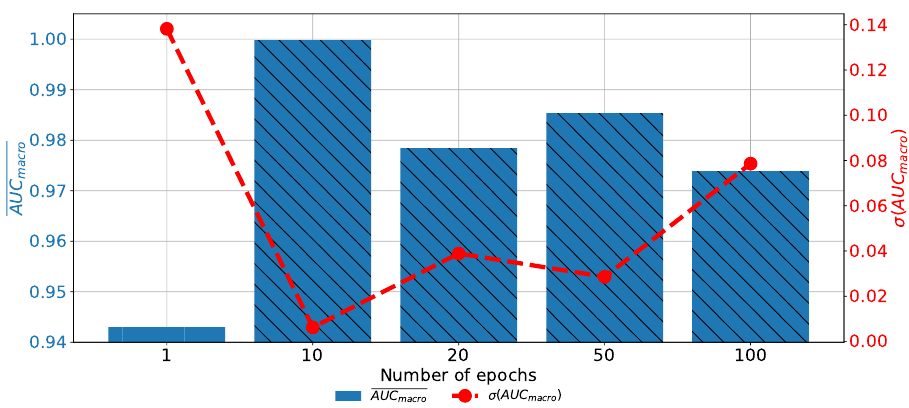
Figure 11. The change of AUC micro and σ ( AUC micro ) through the number of epochs achieved with AlexNet for plane recognition.